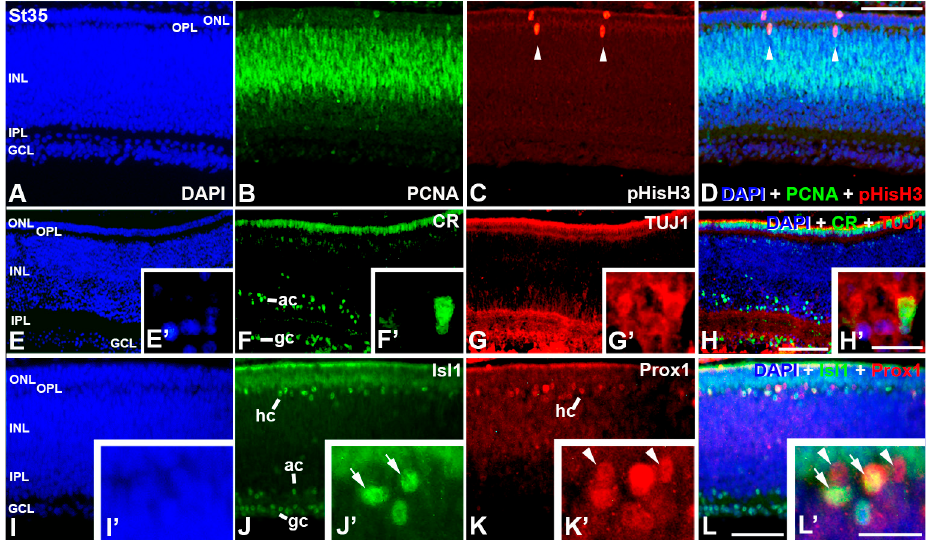
Figure 5. Cell markers in retinal cryosections of C. coturnix at St35 of development. DAPI staining reveals the multilayered structure of the quail retina ( A , E , I ). In the central retina, PCNA-positive proliferating cells are mainly restricted to the outer half of the INL ( B , D ). pHisH3-immunoreactive mitotic figures are sparse and are mainly found in the outer INL and in the ONL (arrowheads in ( C , D )). Abundant ganglion and amacrine cells are immunoreactive against CR ( F , H ) and TUJ1 ( G , H ). A few ganglion cells co-express these markers ( F ′ – H ′ ). Islet1-immunoreactivity identify gan- glion, amacrine and horizontal cells ( J , L ). Prox1-positive nuclei are found in the presumptive hori- zontal cell layer ( K , L ) and some of them also express Isl1 ( J ′ – L ′ ). GCL, ganglion cell layer; INL, inner nuclear layer; IPL, inner plexiform layer; ONL, outer nuclear layer; OPL, outer plexiform layer. Scale bars: 150 µm in A-L; 30 µm in ( E ′ – L ′ ).